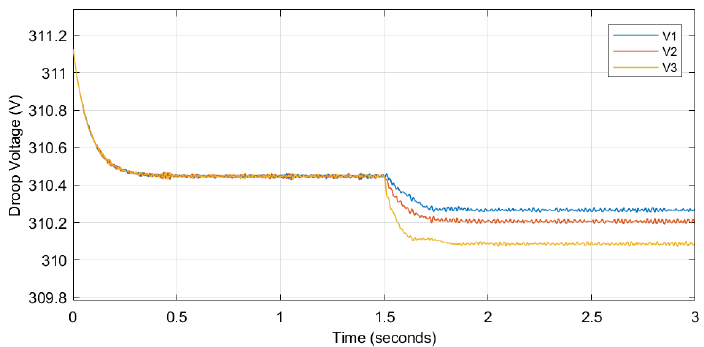
Figure 8. Output voltage reference of the droop controller with typical virtual impedance.